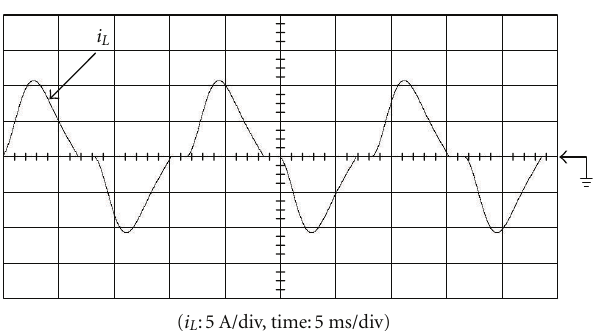
Figure 17: The corresponding inverter current during the interval of high insolation.